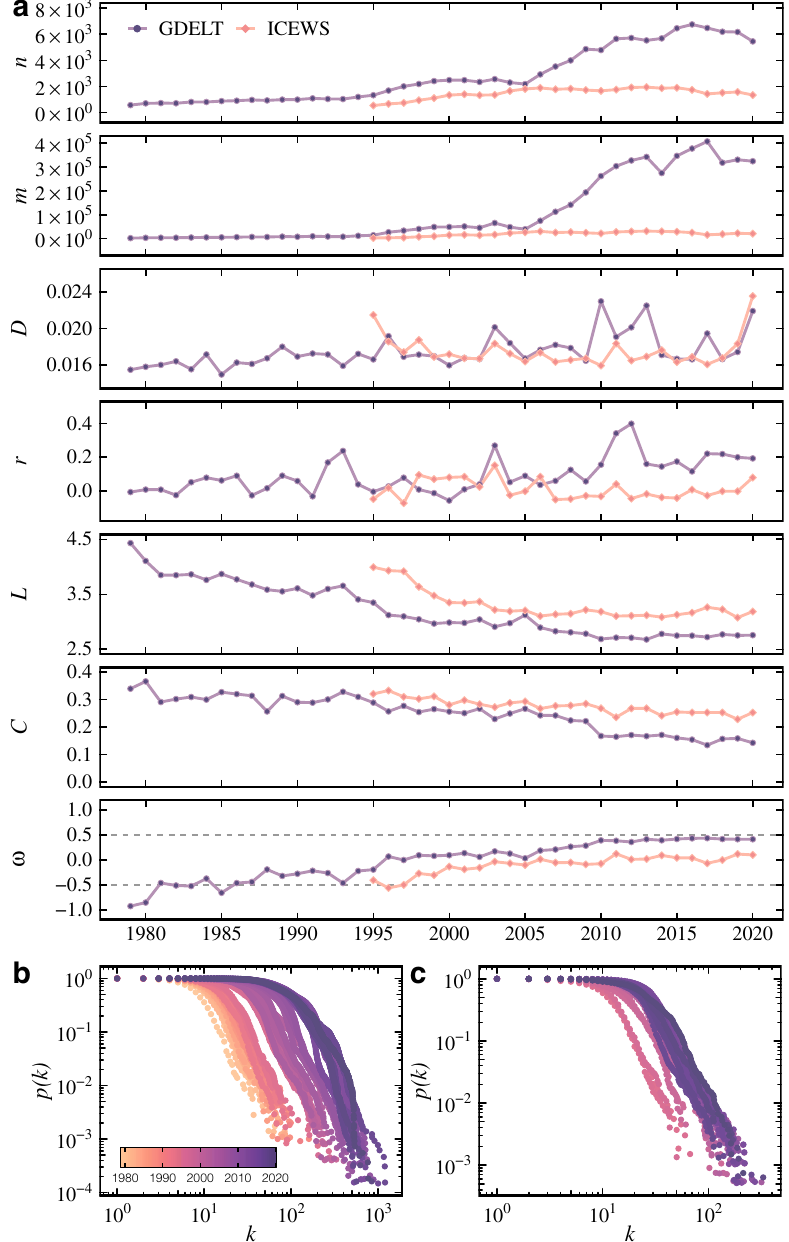
Figure 2. Temporal networks characterization using ( a ) global statistical measures as the number of nodes n , links m , edge density D , assortativity r , average path length L , clustering coefficient C , small-worldness ω , and the degree distributions for the ( b ) GDELT and ( c ) ICEWS data sets. The size of the largest components in both temporal networks corresponds to at least 96% of the number of nodes (cells). Thus, for simplicity reasons and without loss of much information, we report the measures for the largest component in each